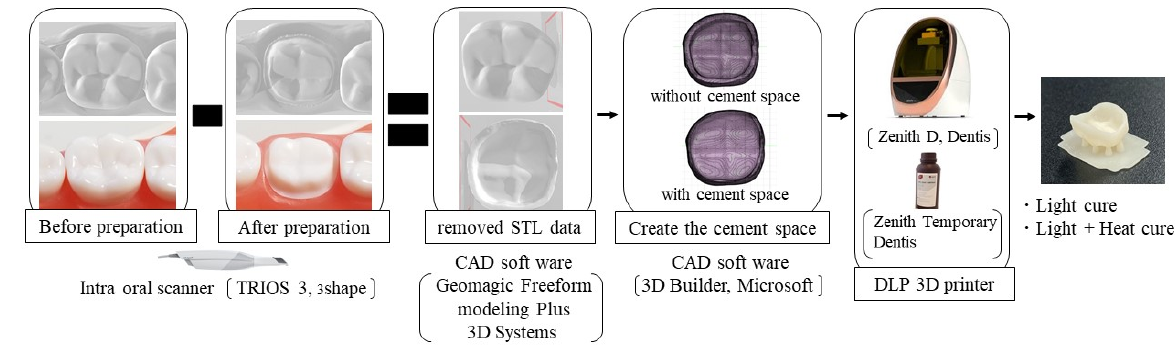
Figure 1. Fabrication of